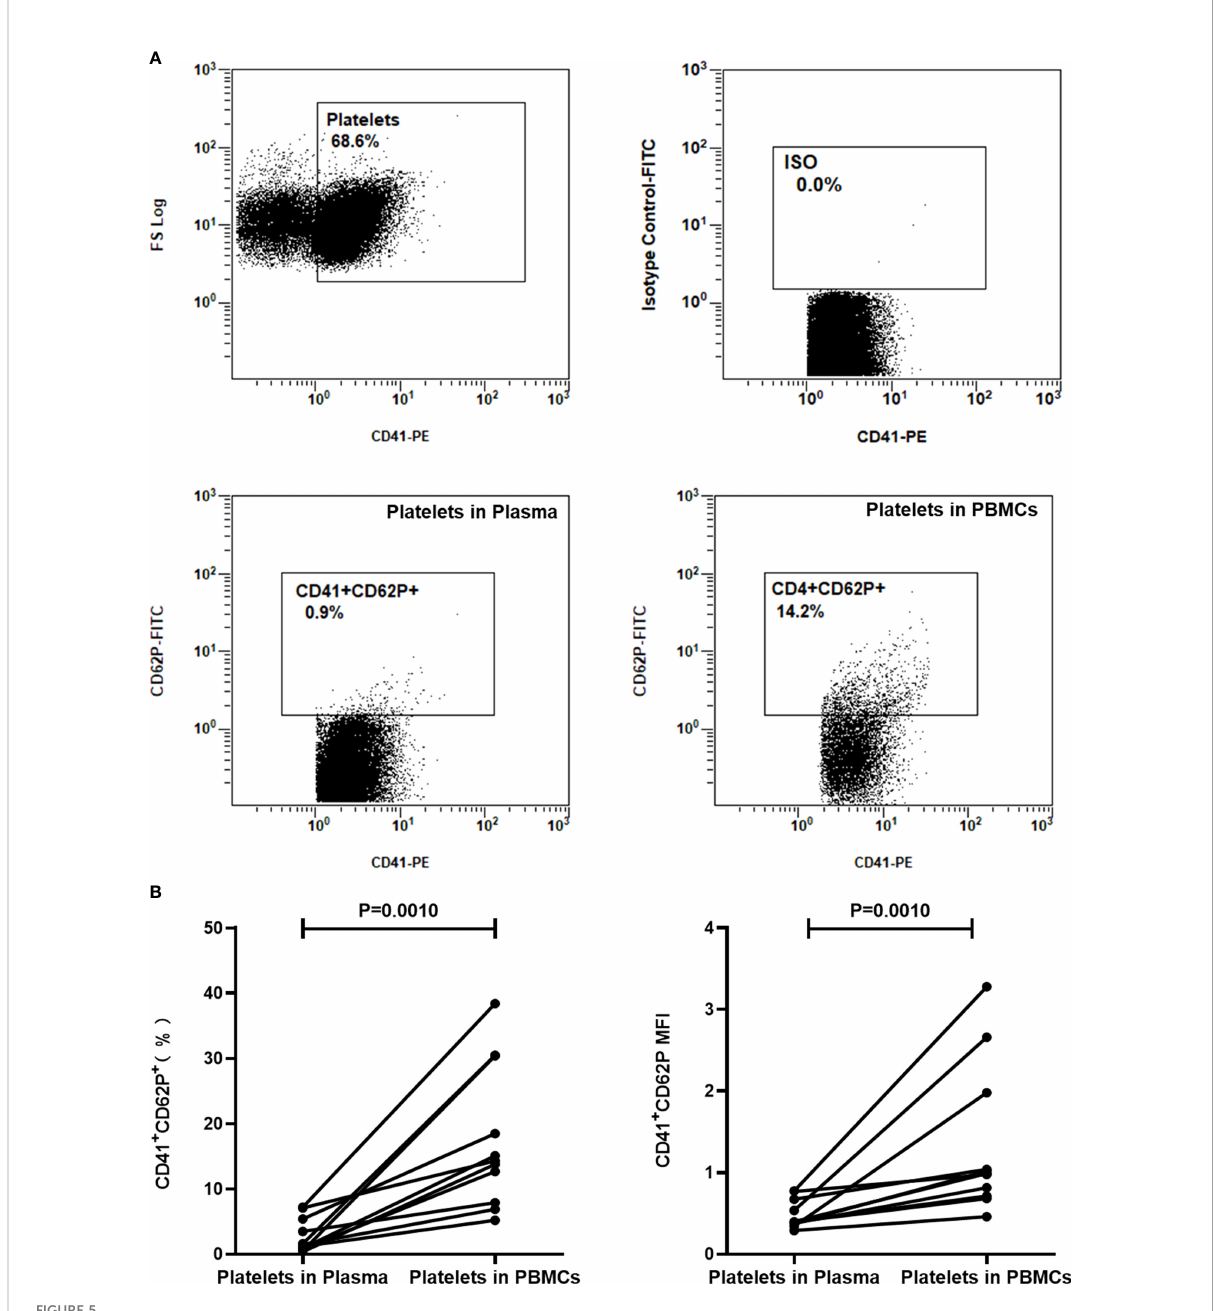
FIGURE 5 The expression of CD62P on platelets in PBMCs was signi fi cantly increased than that in plasma layers. The expression of CD62P in platelets from uncentrifuged plasma layers and platelets from PBMCs separated by density gradient centrifugation was detected by FCM (n=9). (A) Representative fl ow cytometry scatter plots of the expression of CD62P on platelets. Platelets were gated as CD41 + population. (B) The expression of CD62P on platelets in plasma and PBMCs were compared by paired Student ’ s